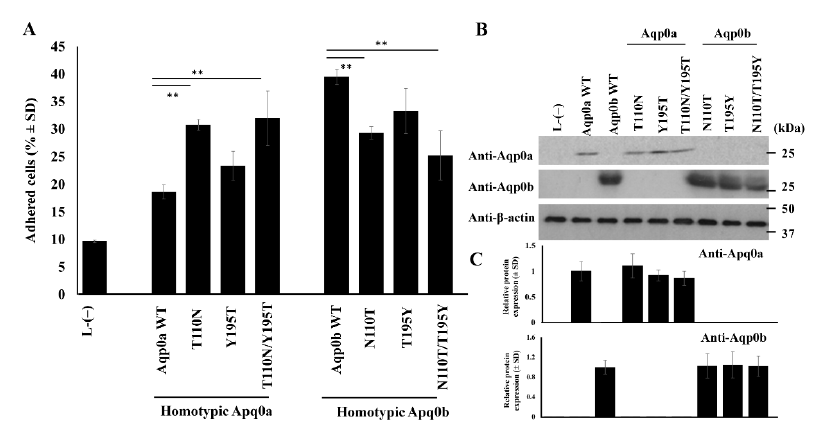
Figure 3. Mutational analysis reveals the importance of site 110 for adhesion of Aqp0b. ( A ) Adhesive properties were tested between homotypic pairs of stable cell lines expressing WT and mutant variants of Aqp0a and Aqp0b. Each lane represents n = 6–8. ( B ) Western blot analysis example showing equal expression of the protein between Aqp0 WT and mutant variants using zebrafish specific rabbit anti-Aqp0a and anti-Aqp0b sera quantified in ( C ) ( n ≥ 3). Statistical differences are shown as ** having p < 0.01.